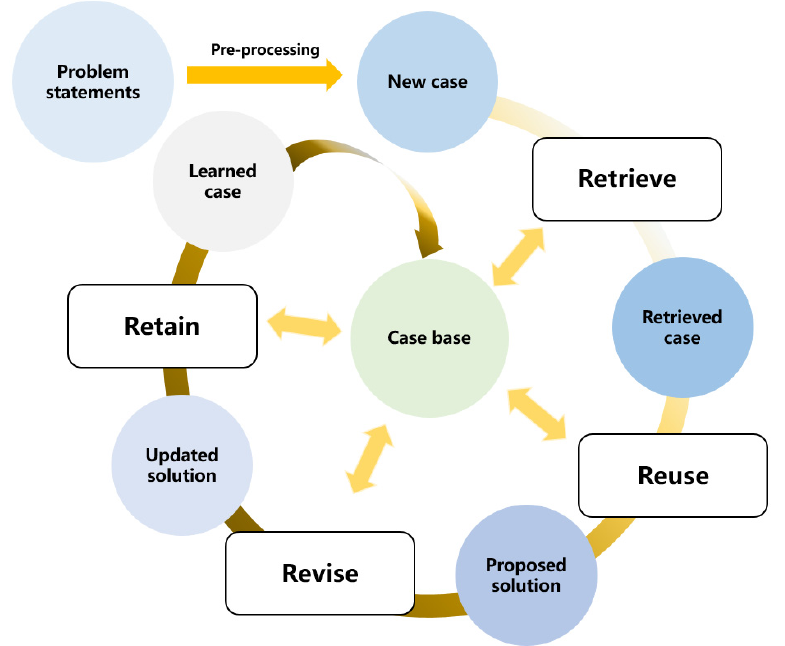
Figure 1. A generic workflow of case ‐ based reasoning.